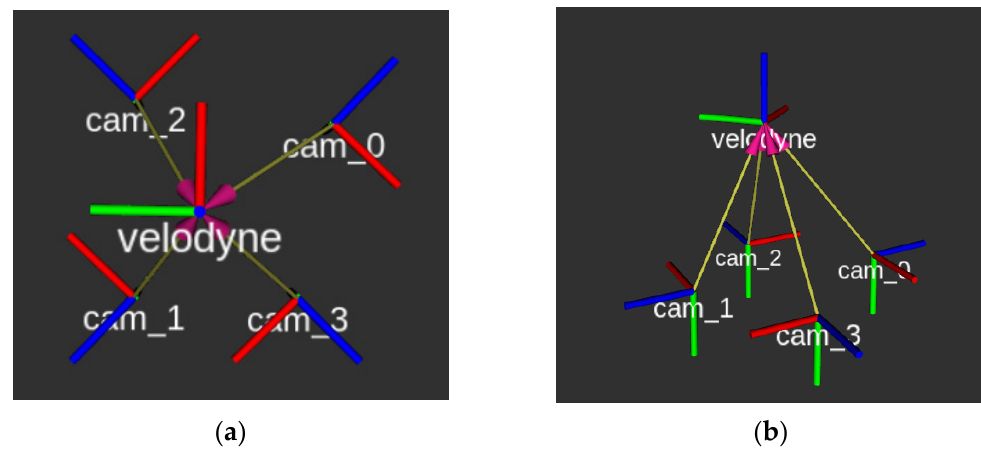
Figure 8. A graphical representation of the transformation of the four camera systems (cam_0, cam_1, cam_2, and cam_3) with respect to the Lidar system (Velodyne). ( a ) Top view. ( b ) Perspective view.